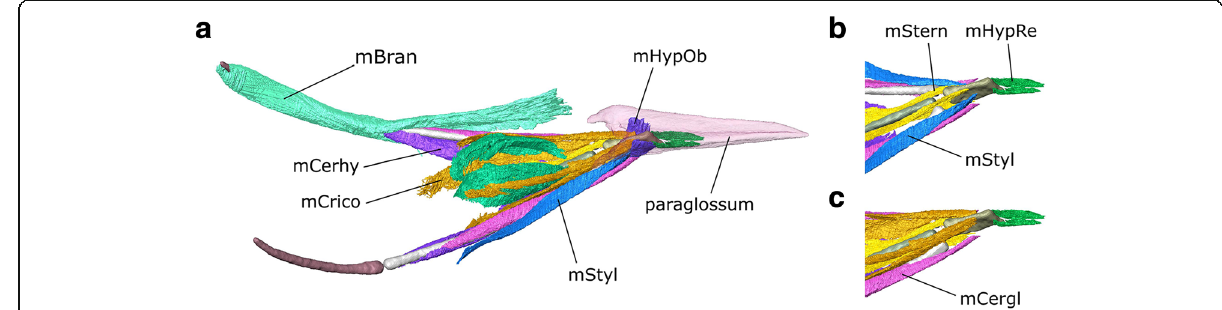
Fig. 14 The throat muscles of Columba livia in lateral view. b and c show only the anterior portion with the paraglossum